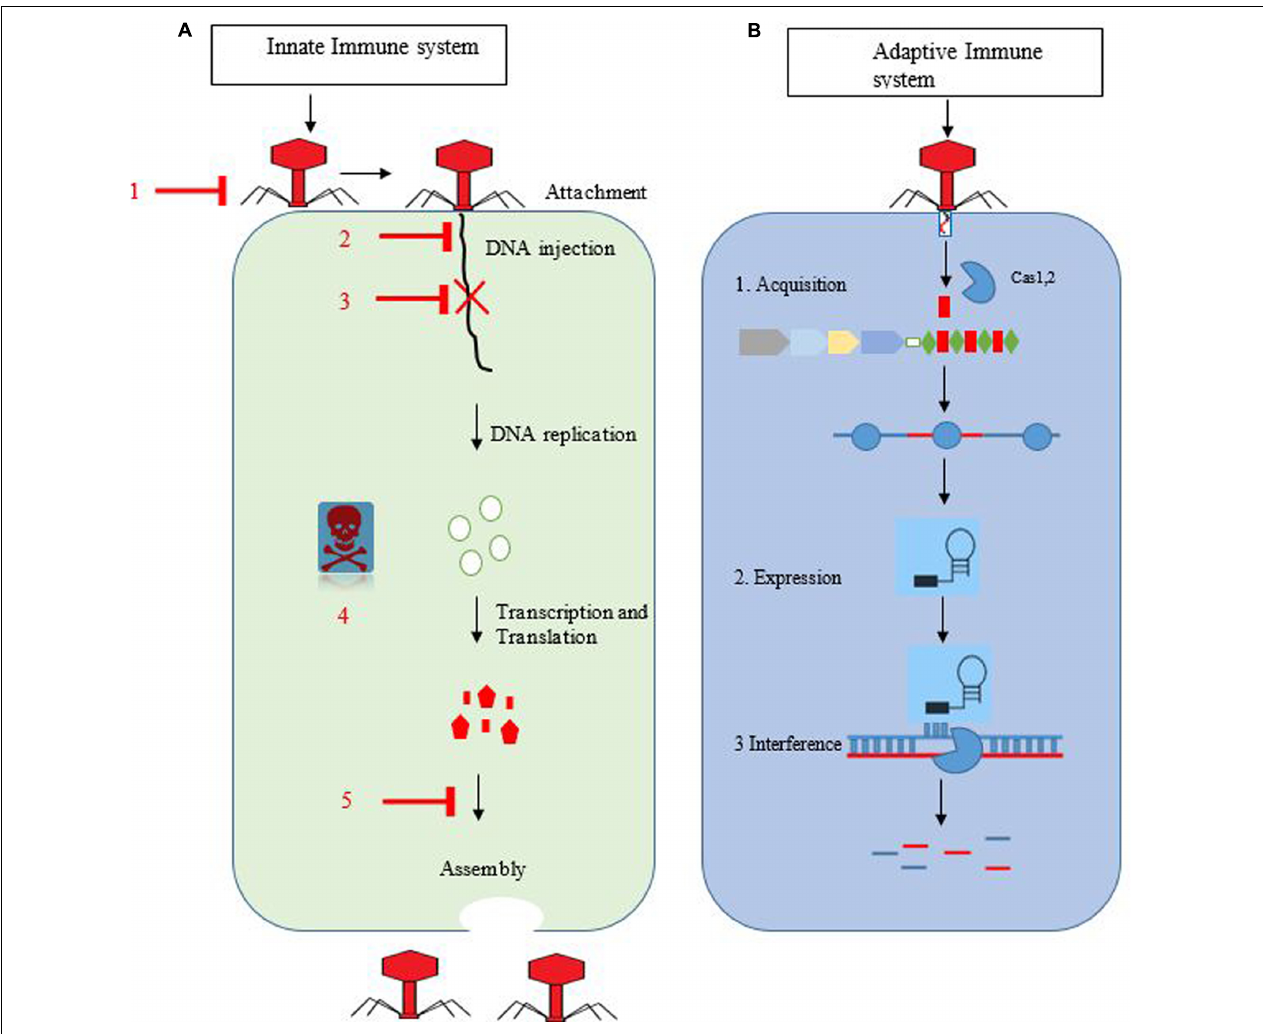
FIGURE 1 | (A,B) Overview of the innate and adaptive immune system of bacteria against bacteriophages. Bacterial anti-phage systems with flat arrow heads. 1 = averting phage adsorption, 2 = blockage of invader DNA entry, 3 = restriction–modification system, 4 = abortive infection, and 5 = interference during assembly. The right side represents stages of bacteriophage replication in host cells. (B) Represents the CRISPR-cas immune system. In the first stage, spacer is integrated with the help of Cas1,2 proteins into the CRISPR loci. In second stage, biogenesis and maturation of pre-crRNA into mature crRNA occur. In the final stage, foreign DNA is cleaved (blue and red stripes) with the help of a specific